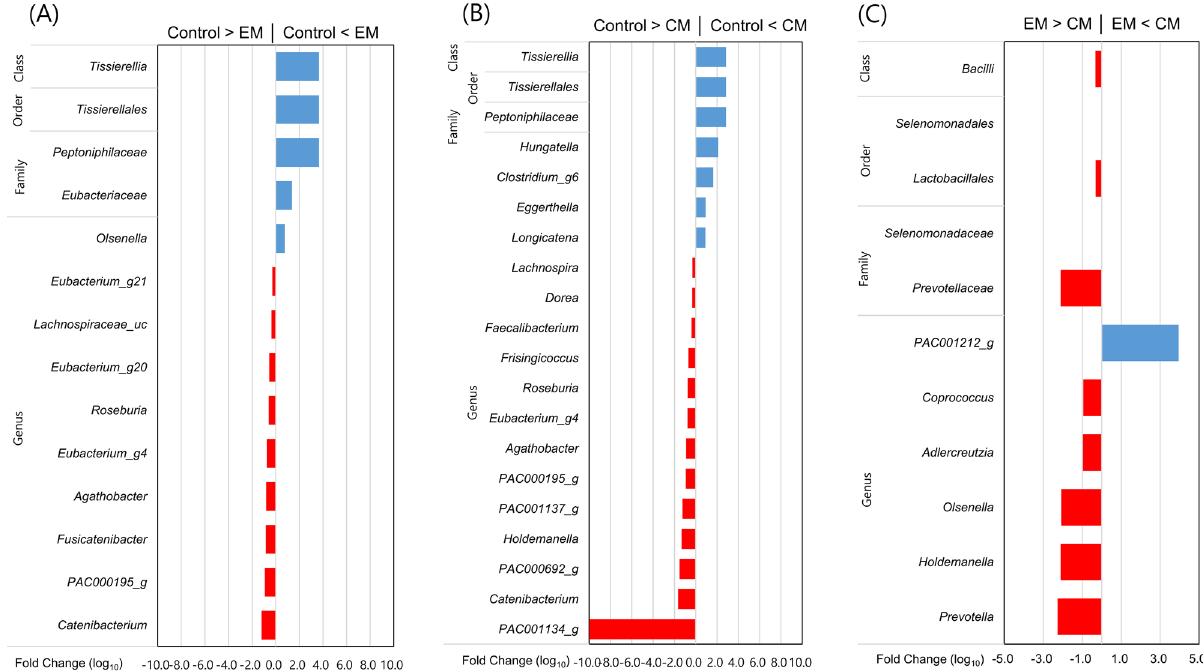
Figure 4. Taxonomic differences in fecal microbiota among participants. The fold change (log 2 ) denotes the difference in relative abundance between participants with episodic migraine and the control ( A ), between those with chronic migraine and the control ( B ), and between those with episodic and chronic migraine ( C ). CM chronic migraine; EM episodic